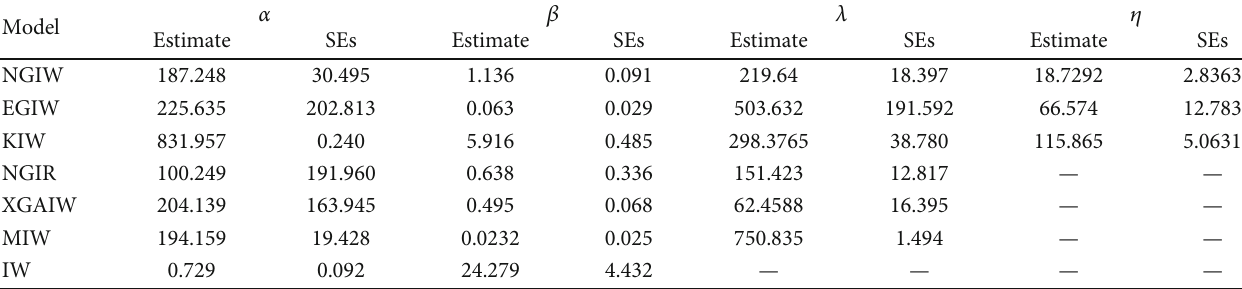
Figure 15: The estimated CDF, fi tted PDF, P-P plot, and Q-Q plot of the NGIW, XGAIW, KIW, and NGIR distributions for complete breast cancer data. Table 7: MLEs and SEs with di ff erent models for medical